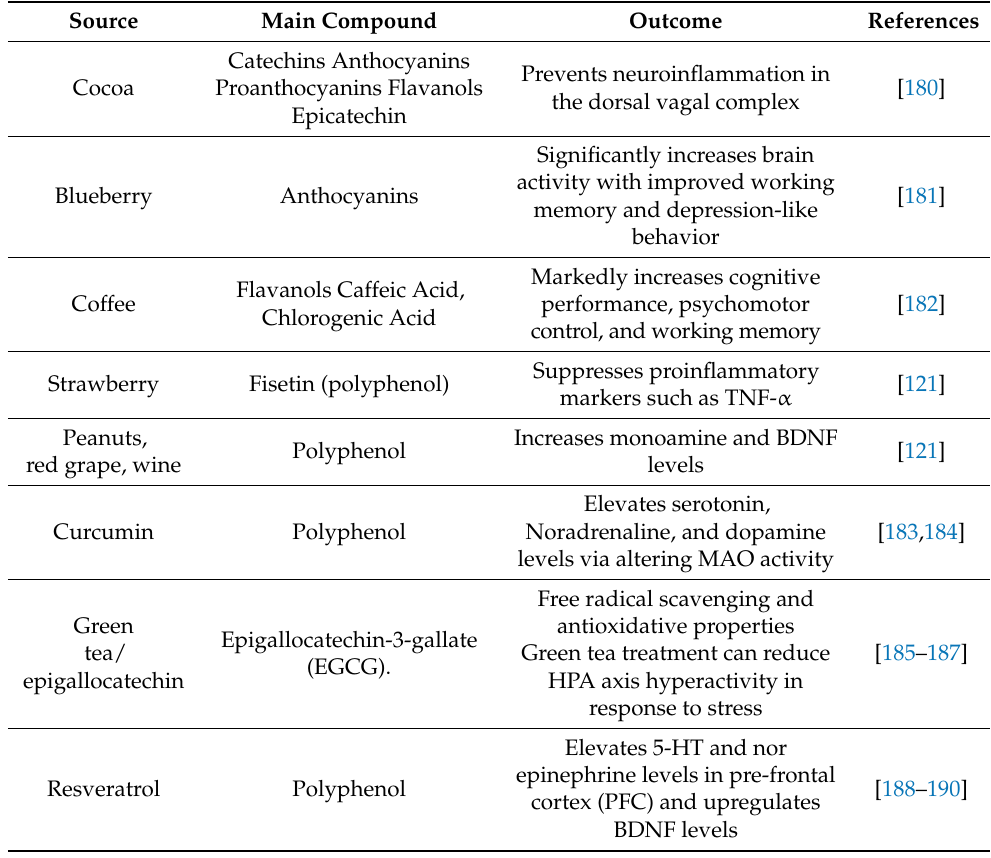
Table 2. Summary of the studies that indicate the potential anti-depressant effects of various polyphenols. Source Main Compound